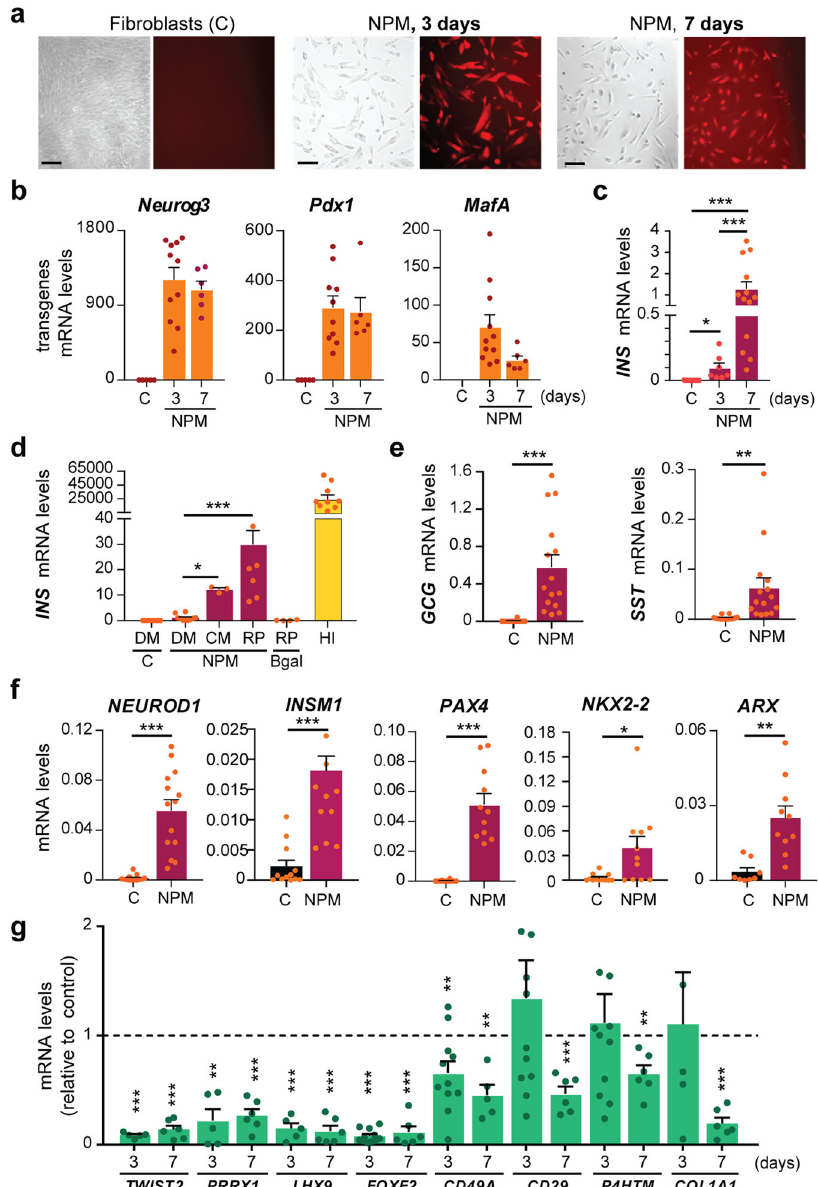
Fig. 1 Introduction of the transcription factors Neurog3, Pdx1, and MafA activates pancreatic endocrine gene expression in human fi broblasts. Human fi broblasts (HFF1) were infected with a polycistronic recombinant adenovirus encoding the transcription factors Neurog3, Pdx1, MafA, and the reporter protein Cherry (Ad-NPM). Untreated parental fi broblasts were used as controls (indicated as C in graphs). a Bright fi eld images and Cherry immuno fl uorescence of control fi broblasts and fi broblasts infected with Ad-NPM at day 3 and 7 post-infection. Scale bar, 100 μ m. b qPCR of transgenes at day 3 ( n = 11) and 7 ( n = 6) after infection with Ad-NPM . c qPCR of human INS at day 3 ( n = 7) and 7 ( n = 13) after infection with Ad-NPM. d qPCR of human INS in fi broblasts maintained in the indicated culture media (DM = DMEM; CM = CMRL; RP = RPMI) during 7 days after infection with Ad-NPM or with an adenovirus expressing B-galactosidase (B-gal) ( n = 3 – 10). In yellow, INS mRNA levels in isolated human islets ( n = 10). e , f qPCR of islet hormone genes ( GCG , SST ) and islet differentiation transcription factors ( NEUROD1 , INSM1 , PAX4, NKX2-2 , ARX ) at day 7 post-NPM ( n = 8 – 15). g qPCR of the indicated fi broblast markers at day 3 ( n = 5 – 11) and day 7 post-NPM ( n = 5 – 6). In b – f , expression levels are expressed relative to TBP . In g , expression is expressed relative to control fi broblasts, given the value of 1 (dotted line). Data are presented as the mean ± SEM for the number of samples indicated in parentheses. * P < 0.05; ** P < 0.01; *** P < 0.001, between indicated conditions using unpaired t -test ( b – f ), or relative to control fi broblasts using one sample t -test ( g